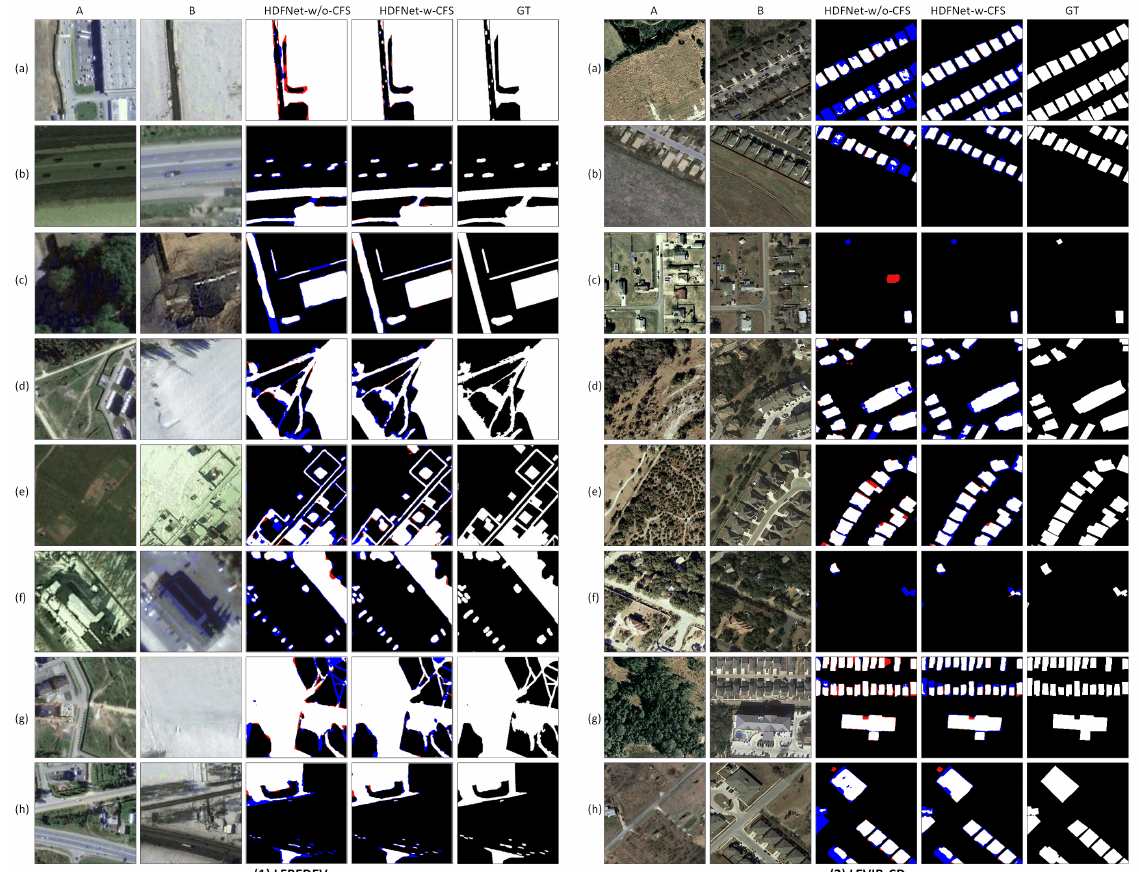
Figure 9. Qualitative ablation study on with/without cross fusion stream (presented as ‘CFS’) of HDFNet on both datasets, represented in (1) LEBEDEV and (2) LEVIR-CD. We select samples ( a – h ) from each dataset. White indicates the changes detected correctly. Black indicates the no change detected correctly. Red indicates the false alarms. Blue indicates unpredicted